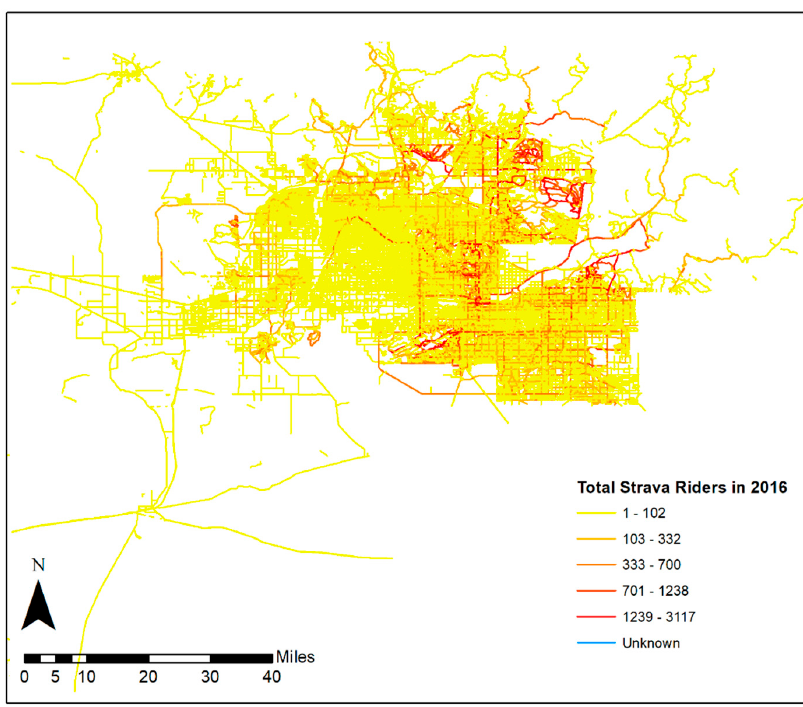
Figure 3. Distribution of Strava riders in Maricopa County for 2016.